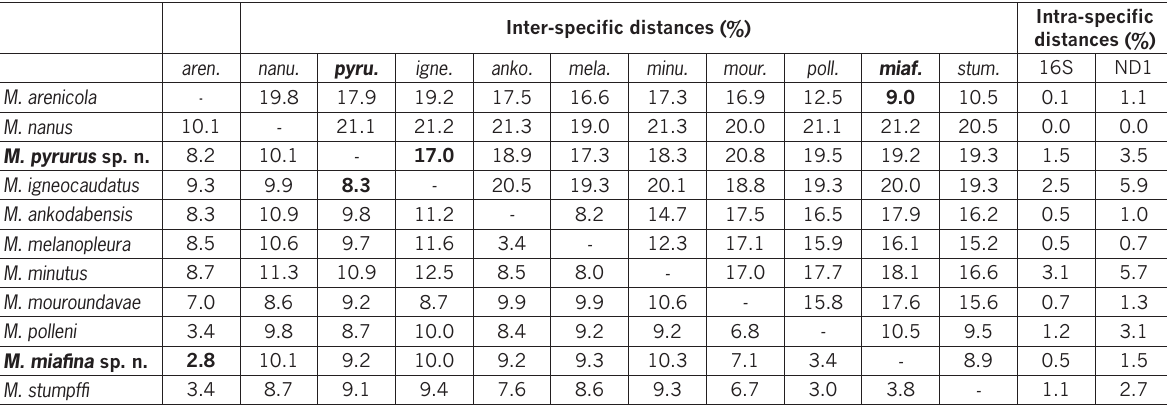
Table 3. Genetic divergences among Madascincus species: mean of the uncorrected p-distances for the ND1 (above diagonal) and the 16S (below diagonal) mtDNA segments estimated between and within the different species. The genetic distance values obtained between the two newly decribed species and their respective sister clades (in bold) are consistent with interspecific divergences observed between the other recognized species of